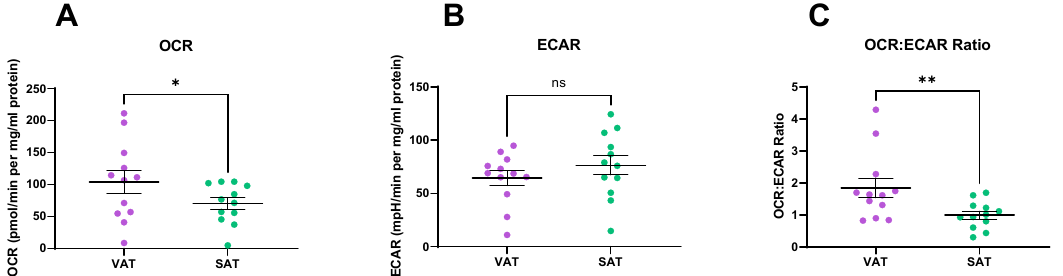
Figure 1. Visceral adipose tissue (VAT) and subcutaneous adipose tissue (SAT) have different metabolic profiles. ( A ) VAT has higher rates of oxidative phosphorylation (OXPHOS) compared to SAT. ( B ) There is a trend towards higher levels of glycolysis in SAT compared to VAT. ( C ) The OCR:ECAR ratio is significantly higher in VAT compared to SAT. Statistical analysis was performed using a Wilcoxon signed rank test. All data expressed as mean ± SEM. n = 12, ** p < 0.01, * p < 0.05, ns = non-significant.